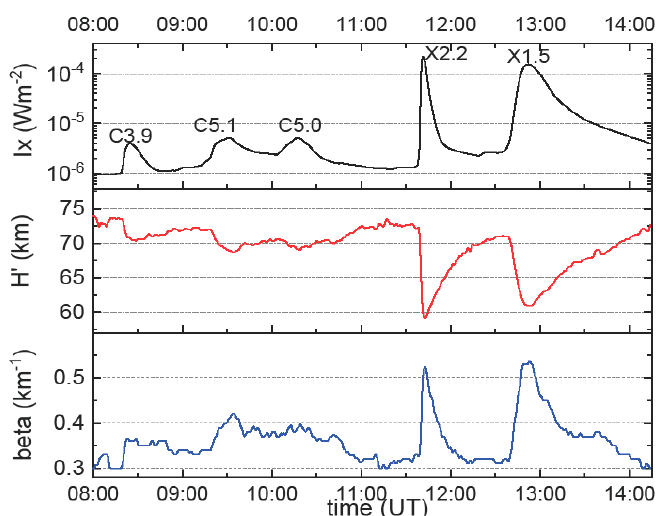
Figure 8. Simultaneous variations of X-ray flux, effective reflection height H ’, and the sharpness β during the occurrence of five successive flares on 10 June 2014 are shown in panels from upper to lower one, respectively.